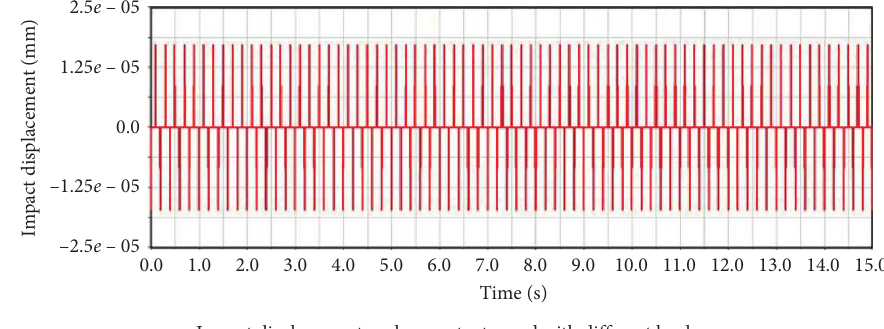
Figure 21: Impact elastic displacement of multistage face gear pair under constant speed and variable load.